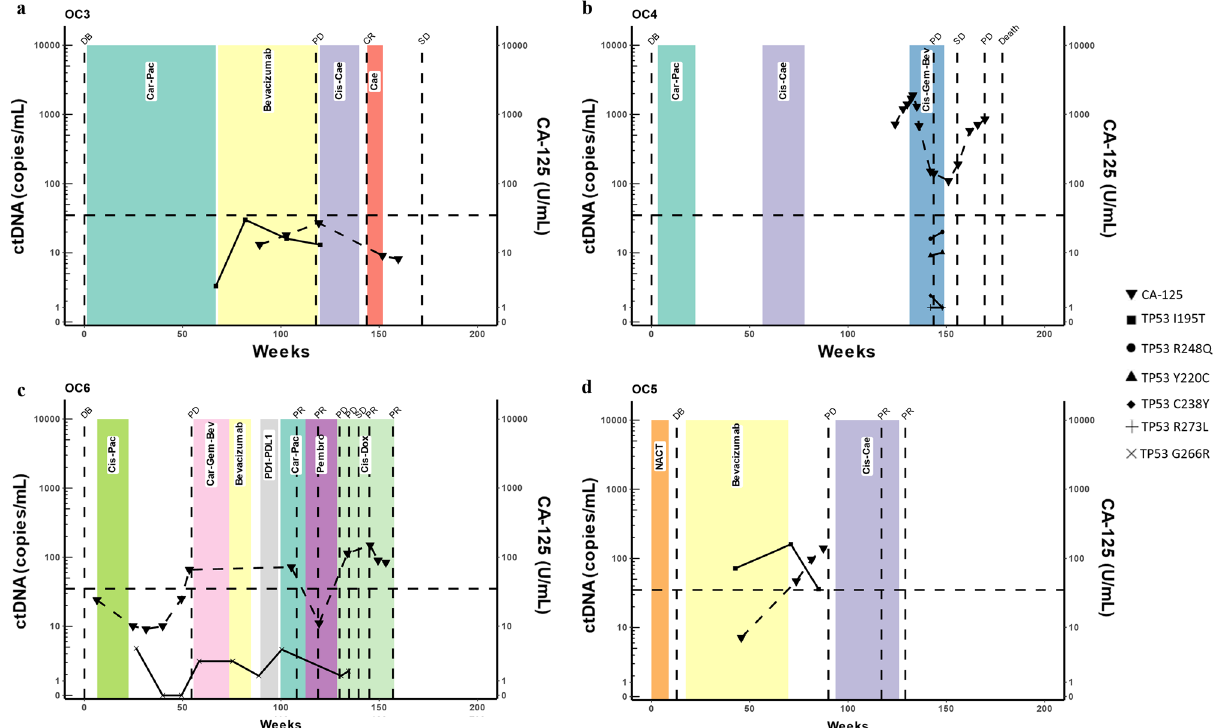
Figure 2. Longitudinal patient monitoring via TP53 mutation in plasma ctDNA. ( a–d ) Line graph denotes the clinical status of four HGSOC patients that were longitudinally monitored throughout their disease course. ctDNA levels indicated by solid lines, different mutations indicated by changing point. CA-125 indicated by dashed line graph with upside-down triangles. Horizonal dashed line indicates the CA-125 positivity threshold of 35 units/mL of blood. Therapy time frames are indicated by coloured boxes with treatment noted in the centre. Vertical dashed lines indicate time of scans or surgery with the outcome named above the line. PD progressive disease, SD stable disease, PR partial response, CR complete response, DB